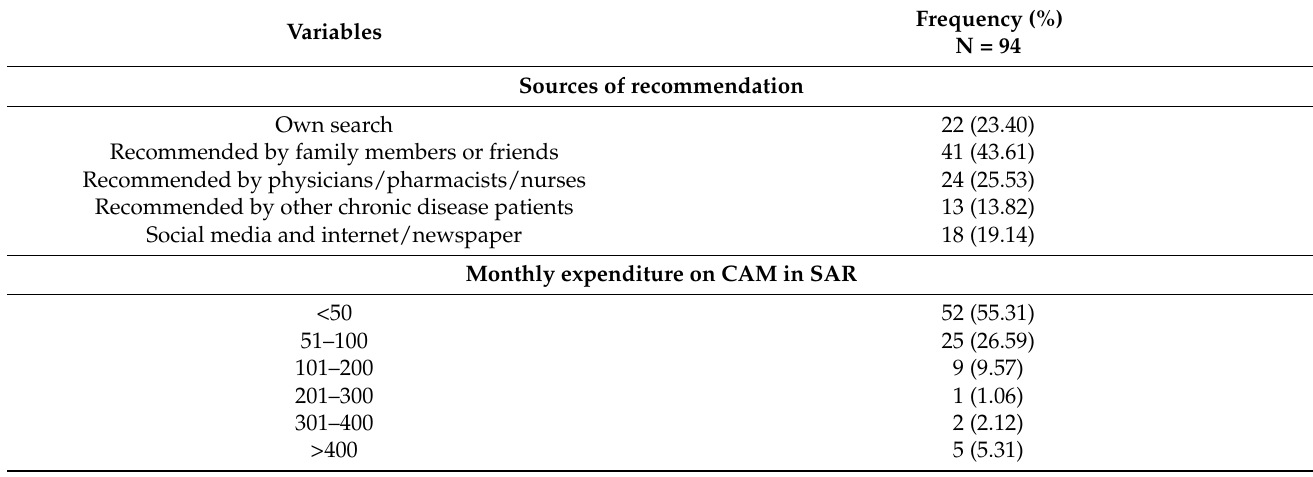
Table 4. Sources of CAM information and monthly expenditure on CAM.